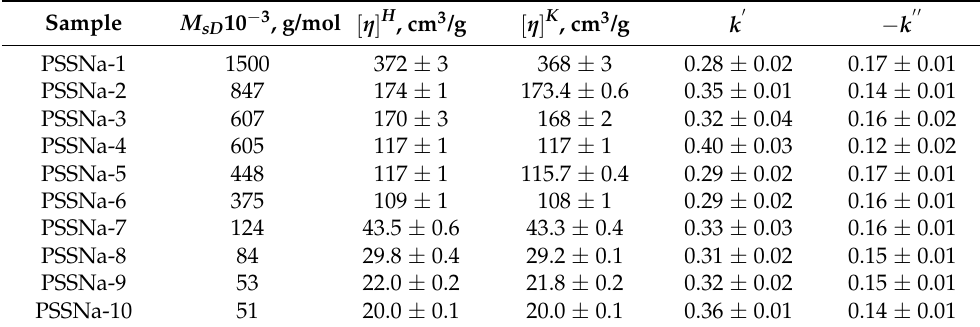
Table 3. The molecular masses M sD , the values of intrinsic viscosities, obtained from Huggins ( [ η ] H ) and Kraemer ( [ η ] K ) plots, and Huggins ( k (cid:48) ) and Kraemer ( k (cid:48)(cid:48) ) parameters for PSSNa in aqueous 0.2 M NaCl at 25 ◦ C. Sample M sD 10 − 3 , g/mol [ η ] H , cm 3 /g [ η ] K , cm 3 /g k (cid:48) − k (cid:48)(cid:48)